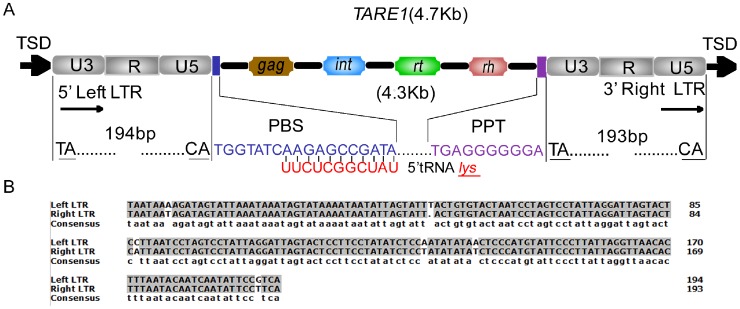
Schematic TARE1 and the LTR sequence comparison.(A) Structural annotation for the TARE1 element. The U3, R and U5 regions of LTR (Long terminal repeat) are shown in gray boxes; ‘TSD’ indicates the 5-bp target site duplication; ‘PBS’ means the primer binding site; ‘PPT’ indicates the polypurine tract; int, rt and rh are the abbreviations for integrase, reverse transcriptase and RNAase-H, respectively. (B) The sequence alignment of two LTRs from a randomly selected intact TARE1 element. The identical nucleotides are shown with gray shadow. The insertions/deletions are marked by dots. The physical positions of this element are located at Chromosome 1 from 27235875 to 27240535.